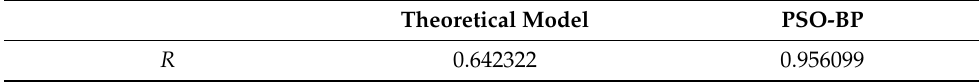
Table 6. Correlation Coefficient of Yield